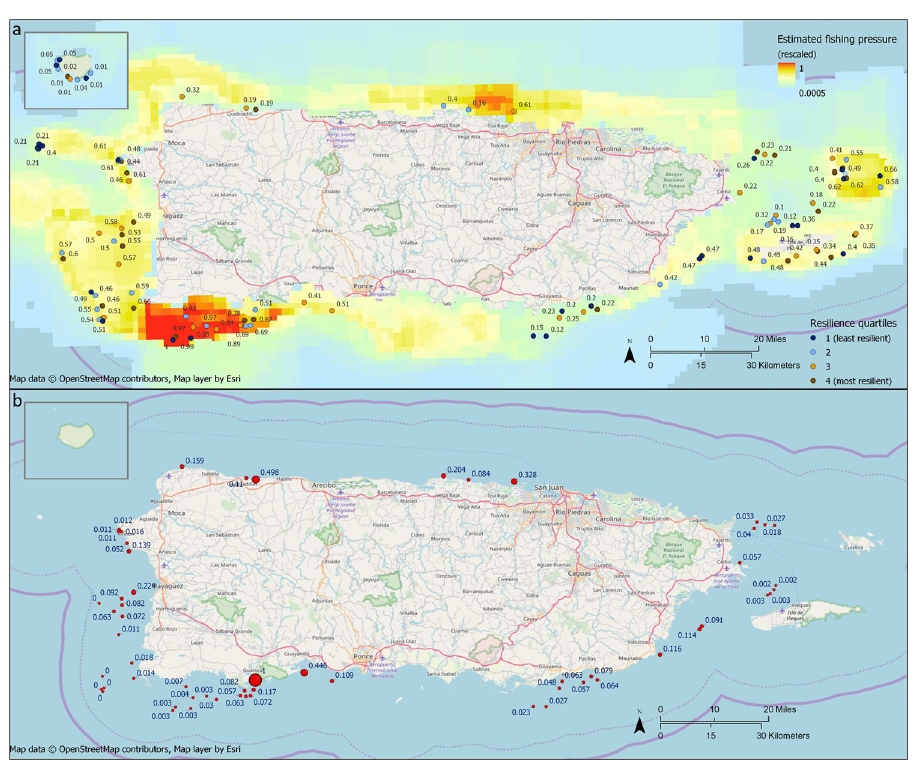
Fig 5. Fishing and land-based sources of pollution (LBSP) stressors, rescaled to a maximum of 1. a) Estimated rescaled potential fishing pressure from lines, nets, traps, and diving (Shivlani & Koeneke, 2011). Numbers are relative fishing pressure. Reef survey sites (n = 103) are coded by resilience quartile. Isla de Mona is the inset in the top left. Resilience quartiles are based on resilience calculated without the temperature variation indicator. b) Rescaled LBSP exposure (sediment and nitrogen) at main island survey sites within 15 km of a river mouth (n = 59). Values are rescaled LBSP (maximum value = 1).